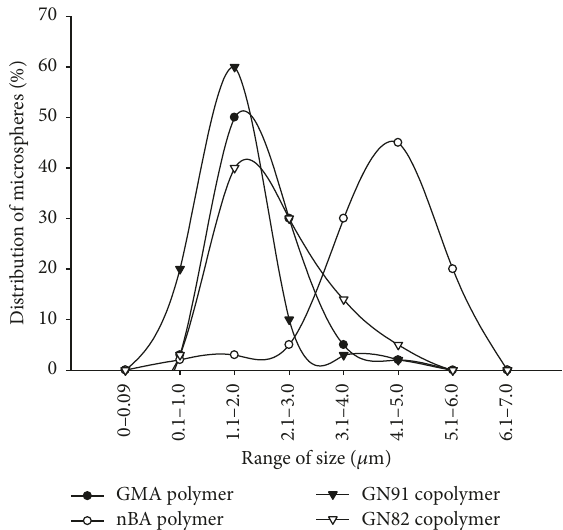
Figure 4: Size distribution for each of conjugated polymers.